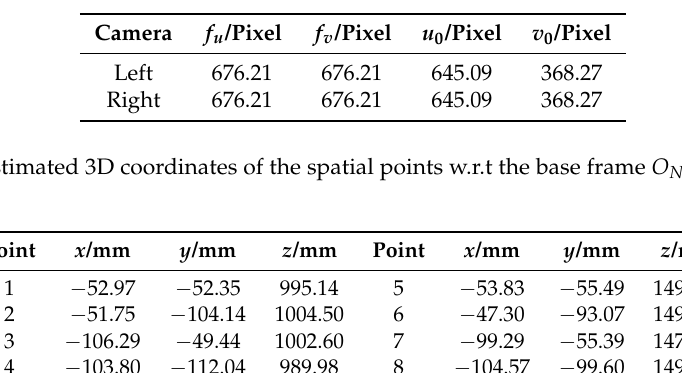
Table 6. The intrinsic parameters of the left and right cameras of ZED mini.